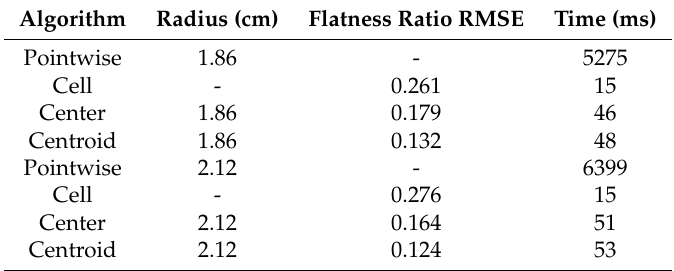
Table 3. Performance of different algorithms for calculating the flatness of the neighborhood of each point in a point cloud. The cell size is 3 × 3 × 3 cm 3